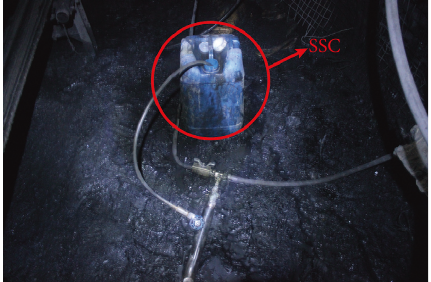
Figure 8: Connection of the duct interconnection required for the SSC application in the coal mine